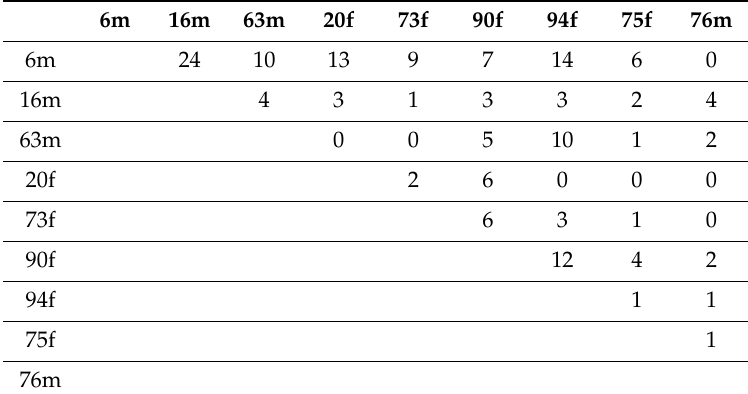
Table 4. Aggression matrix (mean = 4.444; SD = 0.722).